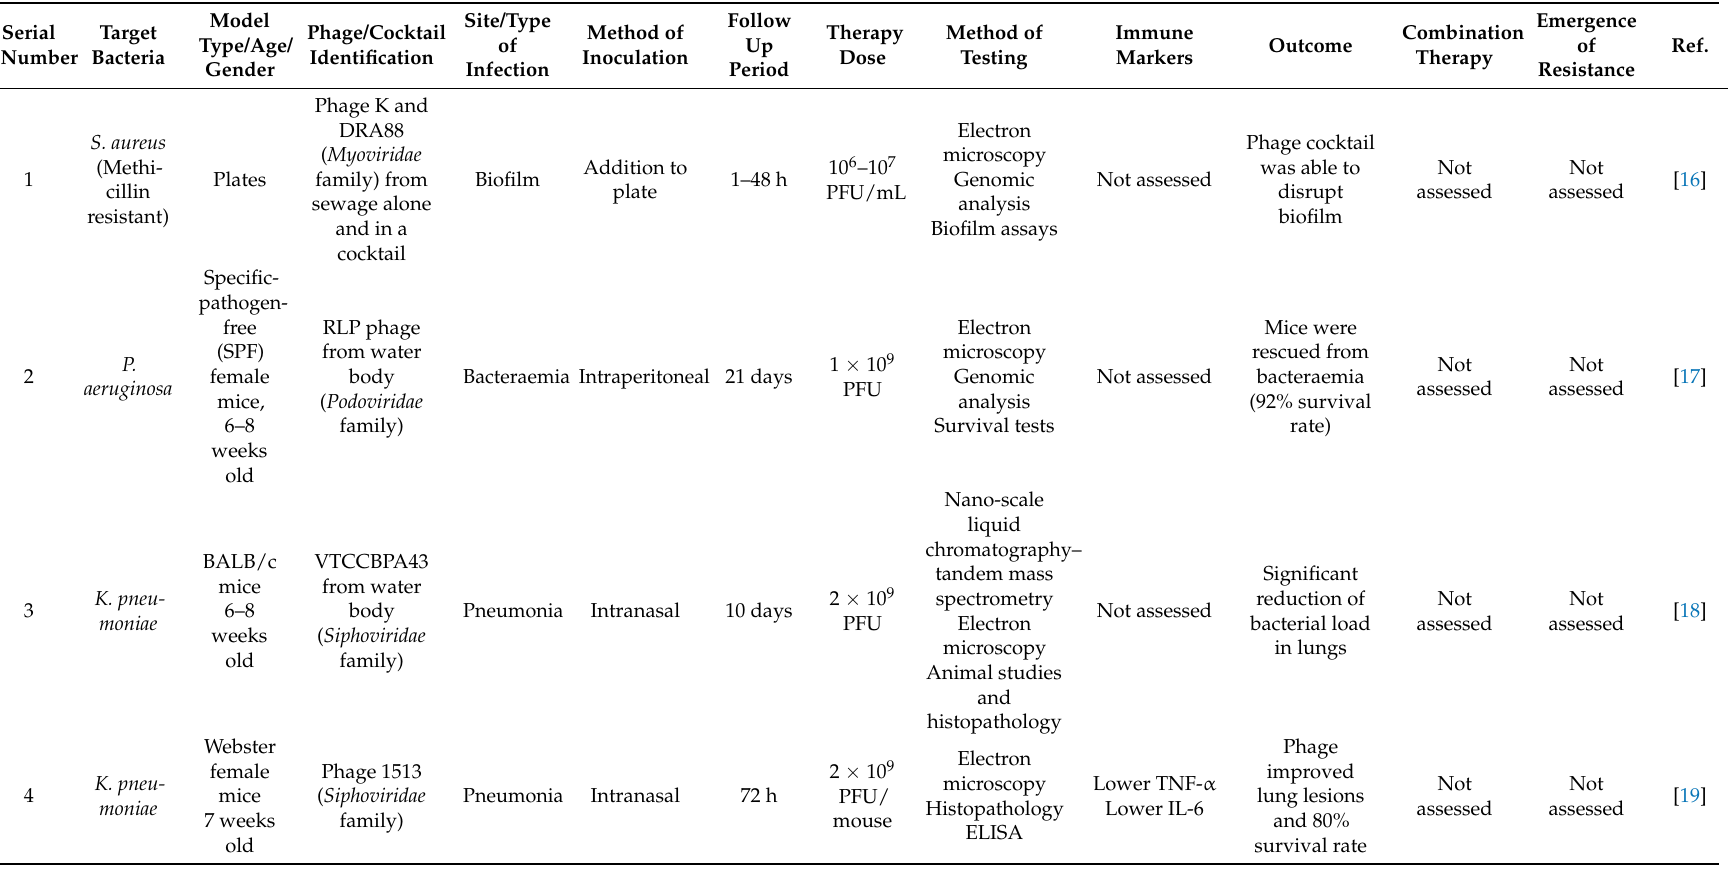
Table 1. Summary of the main features retrieved from 29 reviewed